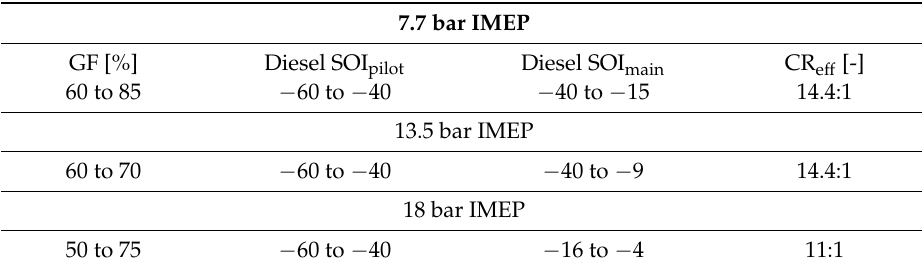
Table 5. Summary of all the tests performed to evaluate the three piston geometries.